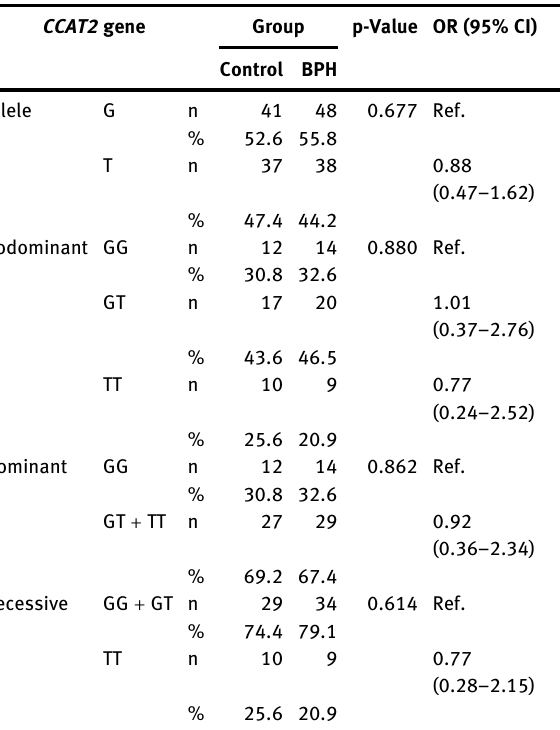
Table  : Single nucleotide polymorphism recorded in the CCAT  gene (rs 